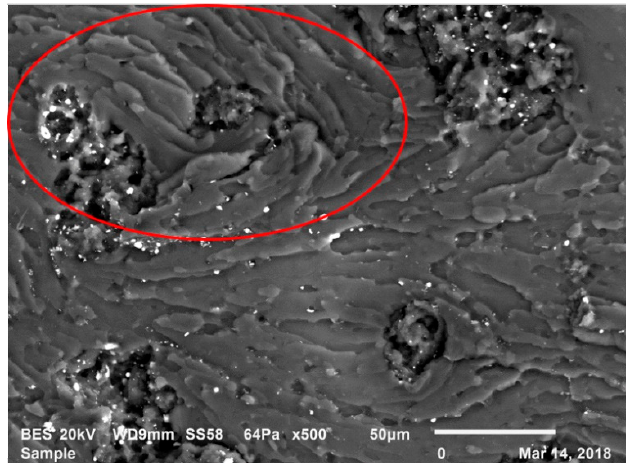
Figure 10. Ductile yielding in the LRG group’s compositions.